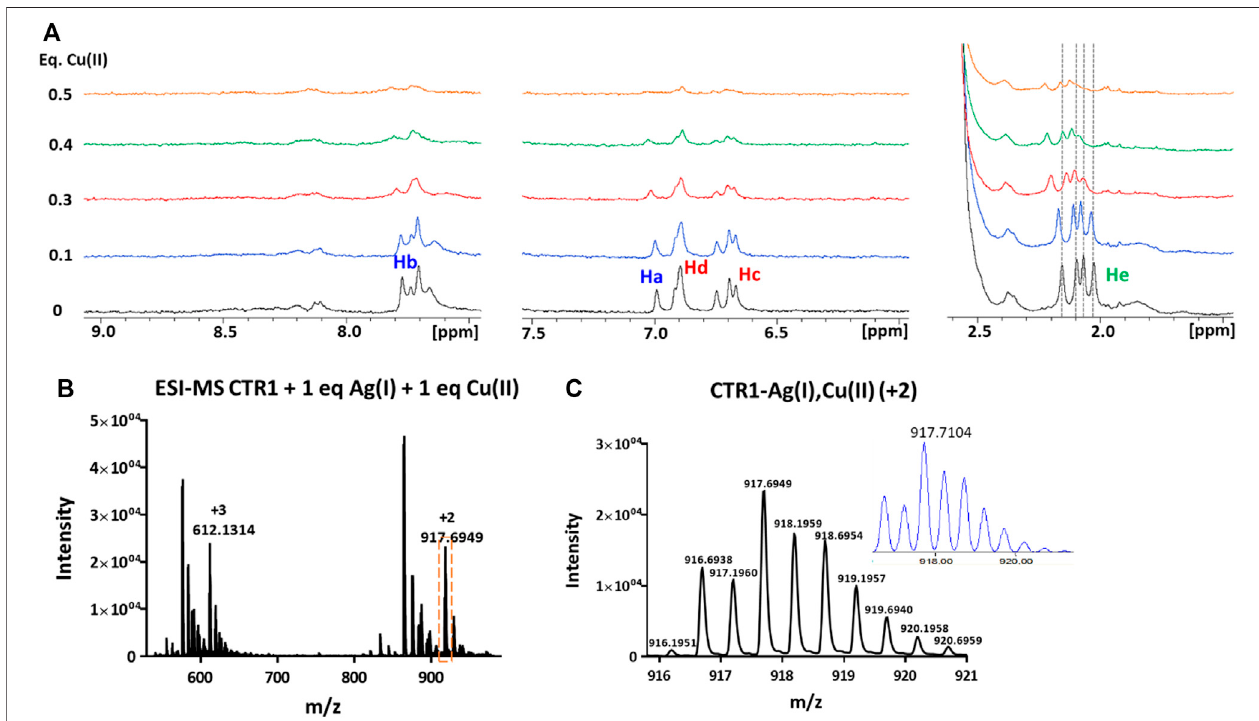
FIGURE 8 | (A) Overlay of three regions of 1D 1 H NMR spectra of Ctr1 1-14 containing 1 eq of Ag(I) in 10 mM MES (pH 7) treated with Cu(II) at different copper: peptide ratios; the dashed lines indicate the positions of the four methyl signals of methionines (He) before addition of Cu(II). Proton assignment scheme as shown in Figure1C . (B) ESI-MSspectraofCtr1 1-14 aftertreatmentwith1eqofAgNO 3 and1eqofCuSO 4 and (C) magni fi cation ofthedoublychargedpeak( orangedashed box in B ); the inset shows the calculated isotope